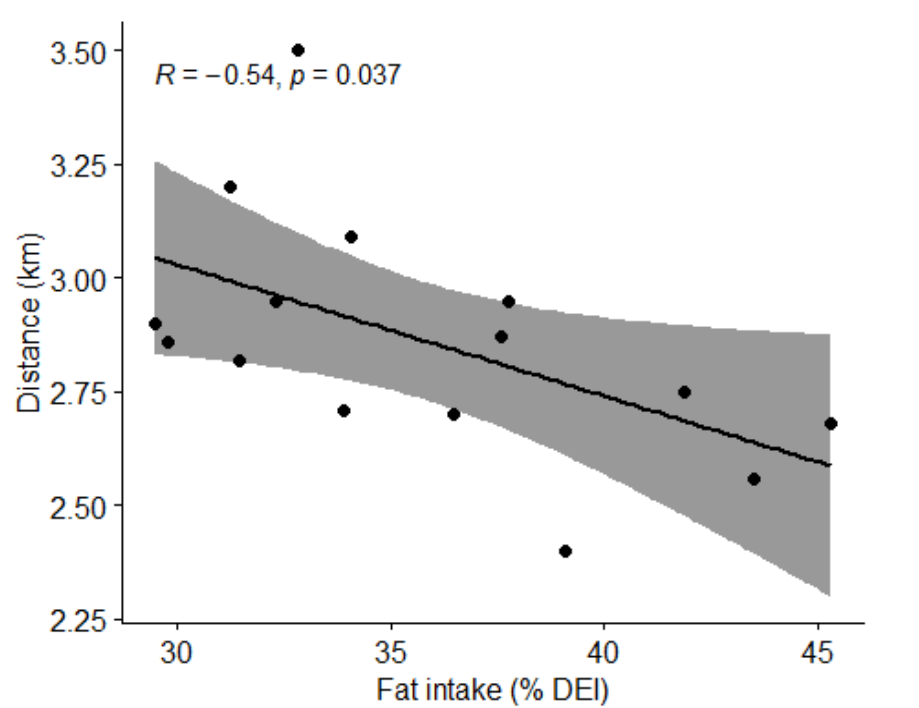
Figure 17. Correlation between the percentage of fat in the diet and distance covered by subjects in the Cooper test. Dots represent individual participants ( n = 15). Grey shaded area indicates 95% CI.